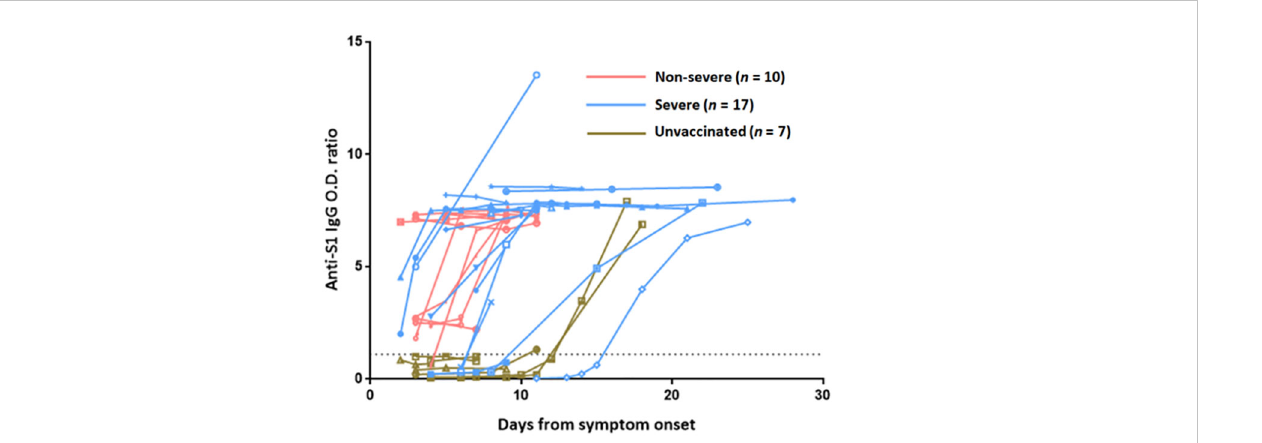
FIGURE 2 Anti-S1 IgG antibody kinetics over time after SARS-CoV-2 infection in vaccinated and unvaccinated patients. Serial antibody titers in vaccinated patients with non-severe ( n = 10) and severe ( n = 17) breakthrough COVID-19 and unvaccinated patients with SARS-CoV-2 infection ( n = 7) are plotted. The dotted line shows the positive cutoff value of the anti-S1 IgG O.D.